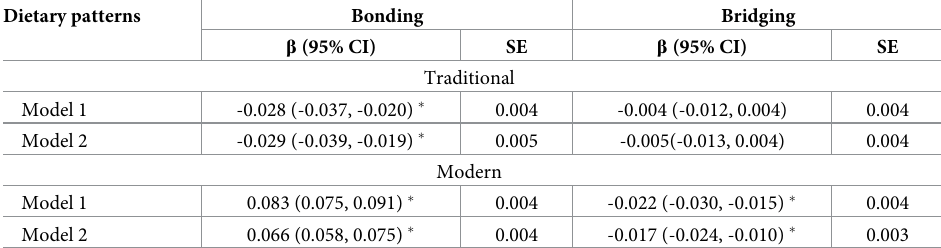
Table 5. Associations of dietary pattern scores with social capital. Dietary patterns Bonding